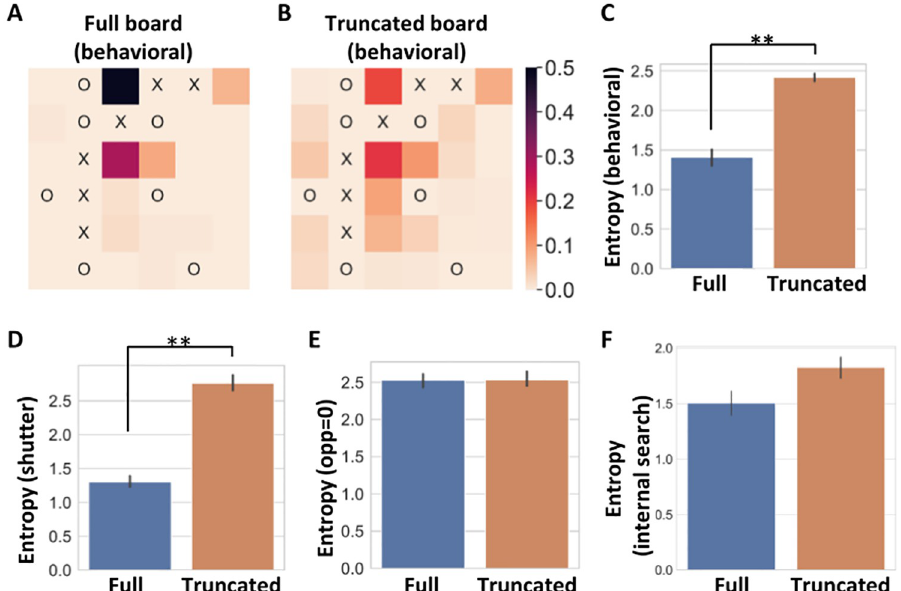
Fig 4. Participants’ search is influenced by their previous choices and is not explained by an internal search model or by reduced attention to the opponent. A) Distribution of participants’ moves on the full version of board configuration II. B) Distribution of participants’ moves on the truncated version of board configuration II. C) Mean entropy of the distribution of participants’ first moves in the truncated boards and the distribution of moves in the equivalent board state in the full boards. D) Mean entropy of the distribution of participants’ first moves in the truncated boards and the distribution of moves in the equivalent board state in the full boards as predicted by the “Interaction” scoring strategies with an added shutter heuristic (shutter = 0). �� , p < 0.01. E) Mean entropy of the distribution of participants’ first moves in the truncated boards and the distribution of moves in the equivalent board state in the full boards as predicted by the “Interaction” scoring strategy when ignoring opponent’s winning paths, thus focusing only on one’s own pieces. F) Mean entropy of the distribution of participants’ first moves in the truncated boards and the distribution of moves in the equivalent board state in the full boards as predicted by an internal search model, using alpha-beta pruning search with branching factor k = 7 and limited depth d = 1. All error bars are 95% confidence